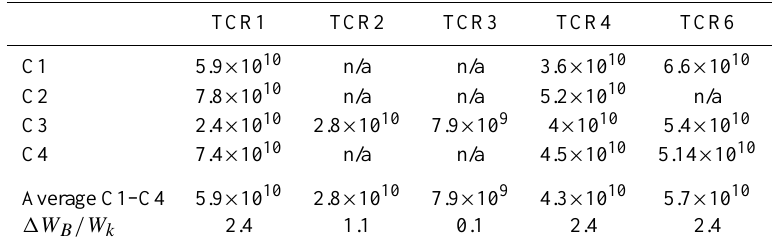
Table 3. Magnetic energy 1W B per unit length of the reconnection line inside the investigated TCRs as calculated from Eqs. (4) and (5) for each Cluster spacecraft C1–C4. For TCR2 and TCR3 only C3 observed an TCR, all other spacecraft engulfed the plasma flow region. The same situation appears for TCR5 where C2 was inside the plasma flow. The energy is mainly in the order of 10 10 Joule per unit length of the reconnection line. The last line gives the ratio between the W B and W k from Table 2 of the five earthward TCRs. As can be seen, the ratio between the magnetic energy inside the TCR and the kinetic energy in the underlying plasma bulge is of the same order. For those TCR, where data from all four s/c was available, the value of the ratio is close to the theoretical value of 2, as predicted by Semenov et al. (1998) and Kiehas et al.